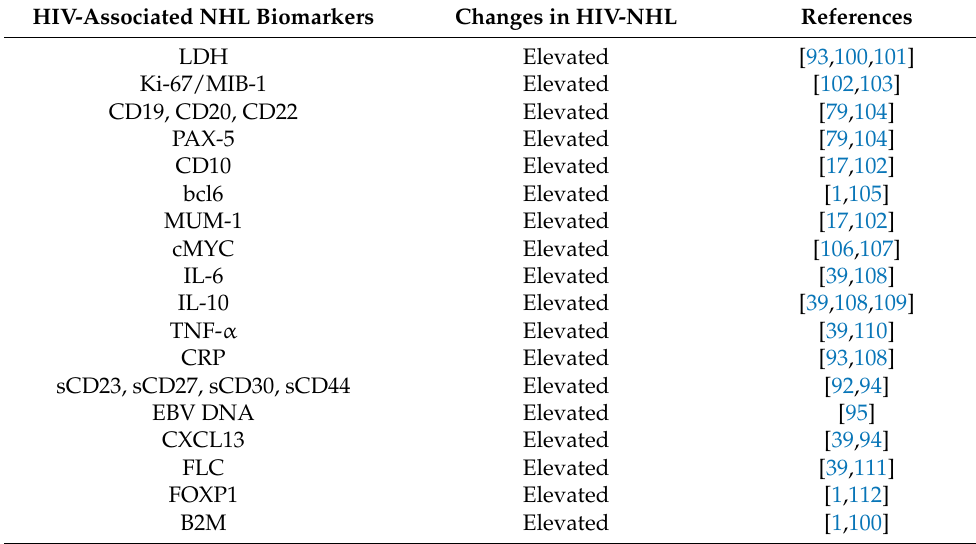
Table 2. Identified biomarkers and the related changes in HIV-associated Non-Hodgkin lymphoma. HIV-Associated NHL